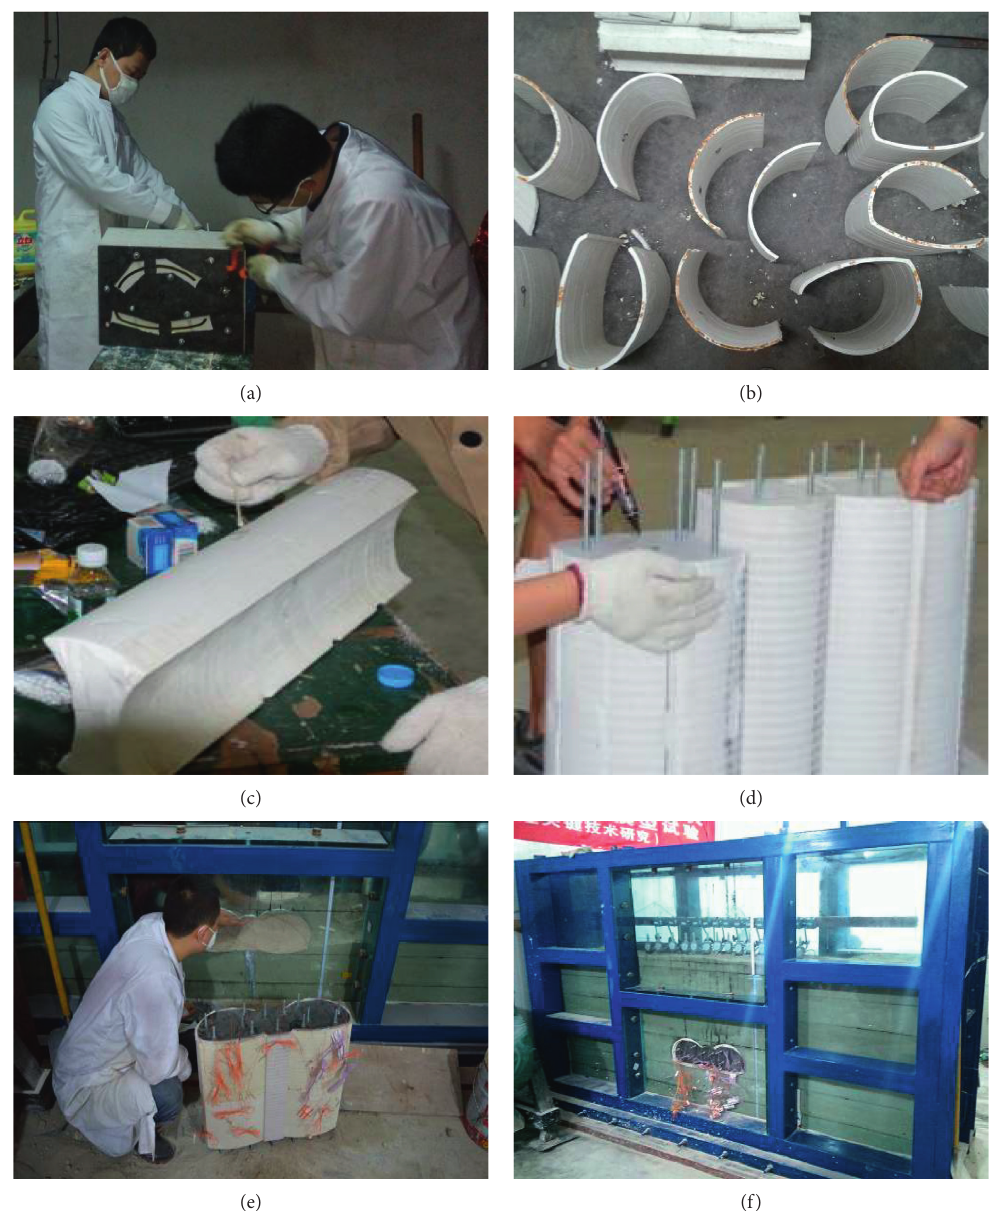
Figure 5: Model component fabrication. (a) Lining pouring mould. (b) Lining components. (c) Midwall. (d) Tunnel model. (e) Model and measuring element. (f) Buried tunnel